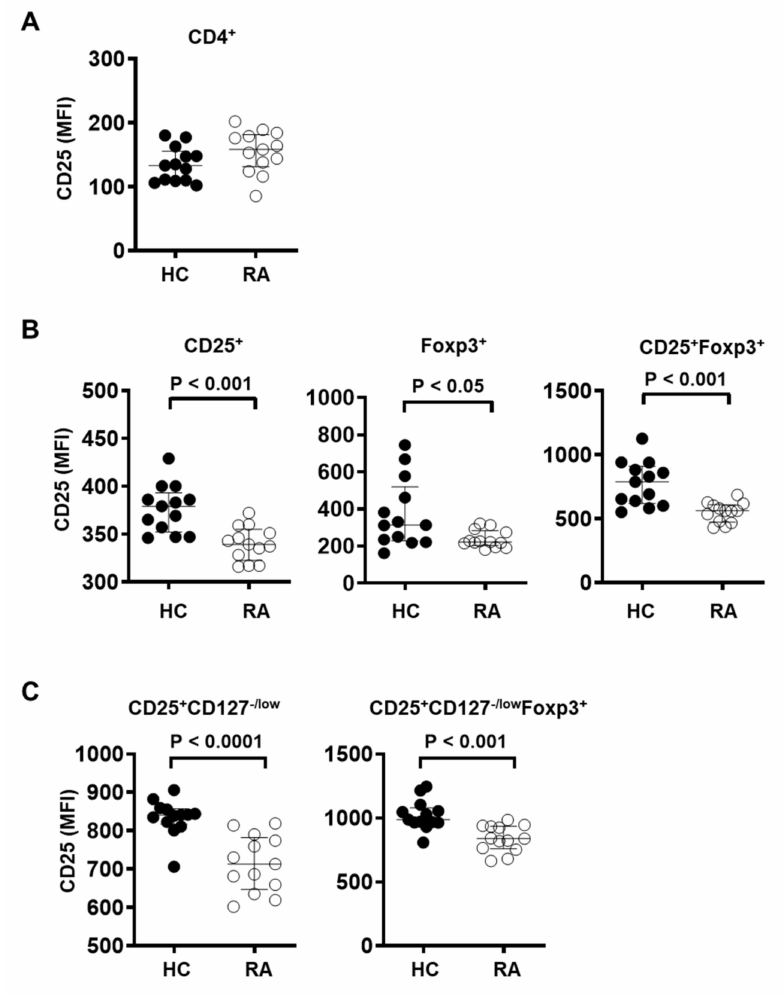
Figure 3. T reg cells from RA patients show decreased CD25 expression. CD25 expression level was measured by flow cytometry in ( A ) CD4 + T cells, ( B ) CD4 + CD25 + , CD4 + Foxp3 + , or CD4 + CD25 + Foxp3 + T reg cells, and ( C ) CD4 + CD25 + CD127 − /low , CD4 + CD25 + CD127 − /low Foxp3 + T reg cells in PBMC from healthy controls (HC, n = 13) and RA patients (RA, n = 13). Statistical differences were calculated by Mann–Whitney